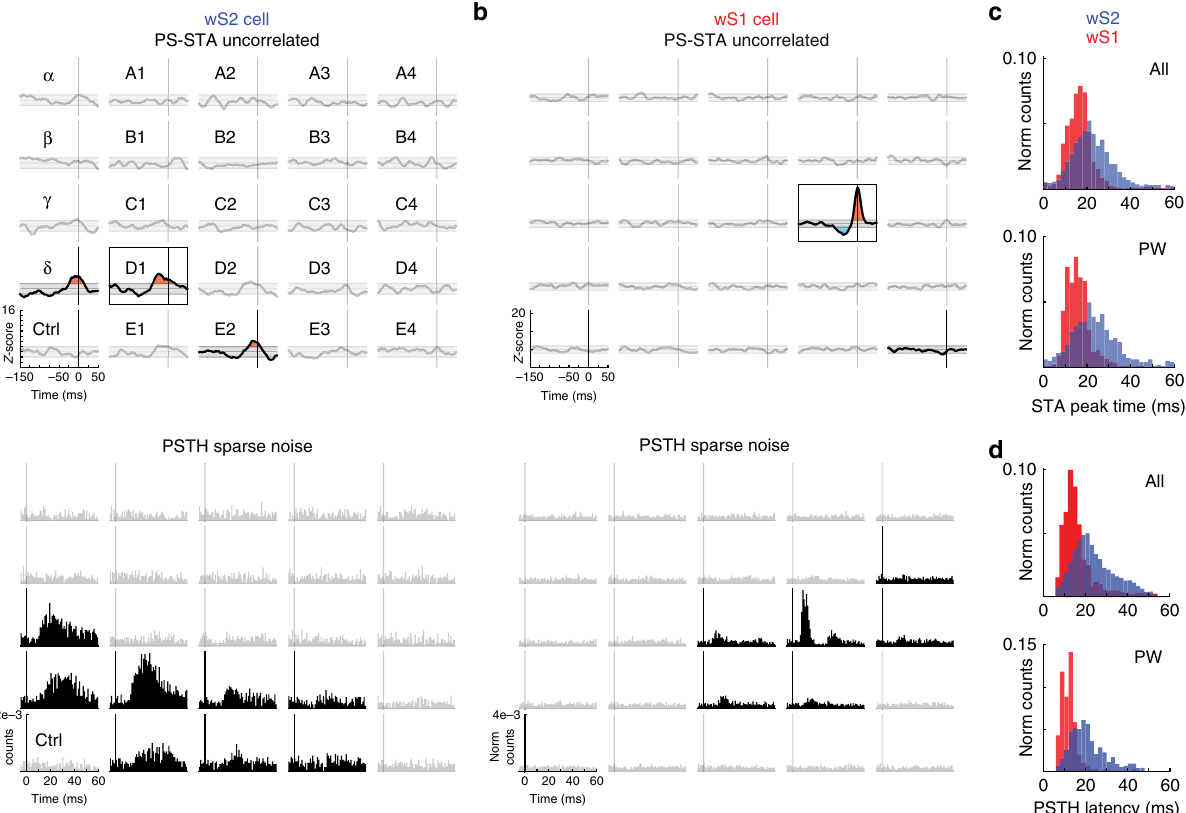
Fig. 4 TPM reveals whisker-pad scale spatio-temporal dynamics. a , b Top: PS-STAs under continuous uncorrelated Gaussian white noise for the same neurons shown in Fig. 3. Each whisker subplot is z-scored as in Fig. 3c, d. Non-faded subplots are signi fi cant responses based on the windowed energy compared to a shuf fl ed stimulus distribution (see Methods). Signi fi cant responses are shaded for high-PS tuning (red) and low PS tuning (blue). Black boxes delineate the strongest whisker (largest integral of the curve). A to E: whisker rows, Greek letters: straddlers, 1 to 4: whisker arcs. Bottom: Receptive fi elds mapped using sparse noise. Each whisker subplot is a PSTH aligned to the stimulus (including stimulus from caudal and rostral de fl ections for each whisker). Non-faded subplots are the ones with signi fi cant PSTH responses compared with the blank (bottom left) based on a surprise analysis (see Methods) for each direction. a wS2 cell. b wS1 cell. c The peak time of the PS-STAs for the populations in wS2 and wS1 shown for all whiskers (All) in the top plot and the principal whiskers (PW) in the bottom plot. The wS2 peak times are adjusted by the Δ t found in Fig. 1g for a realistic depiction of the distribution compared with wS1. d Latency distributions for all cells from wS2 and wS1 for all whiskers (top) and principal whiskers (PW, bottom). As expected, these distributions match well with c . Latencies in wS2 for all whiskers are 23 ± 10 ms (median 21 ms) and for the PWs only are 20 ± 9 ms (median 18 ms) for 681 cells and 5489 whiskers. In wS1, latencies are 14 ± 7 ms for all whiskers (median 12.5 ms) and 10 ± 4 ms for PWs only (median 10 ms) for 152 cells and 994 whiskers. All ± values are standard